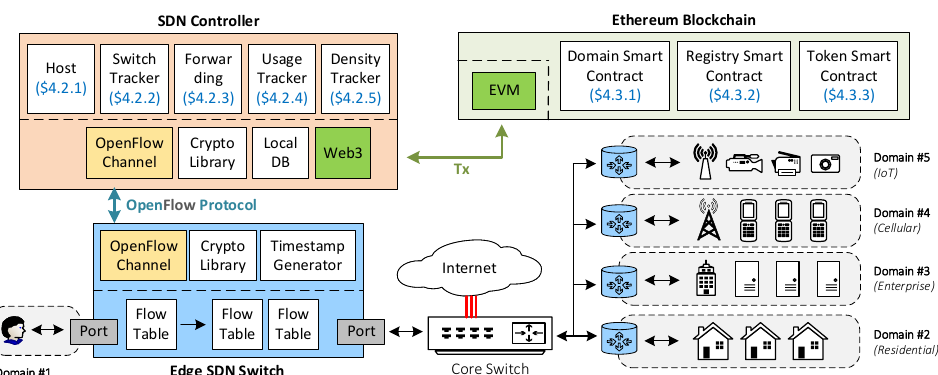
Flow Flow Port Table Figure 1. The system architecture of RealPrice consisting of SDN edge domains, SDN switches, SDN controllers, and the Ethereum blockchain network. RealPrice can be used in any edge network, such as residential, enterprise, cellular, or IoT